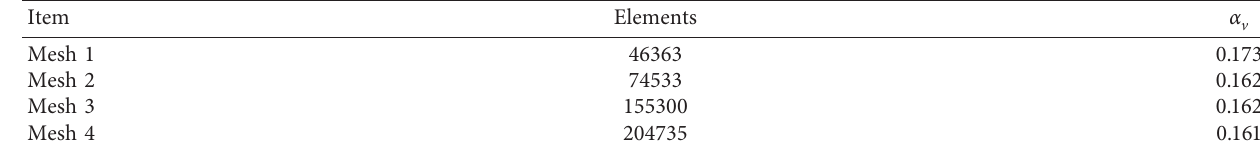
Table 1: Axial piston pump mesh independence test.